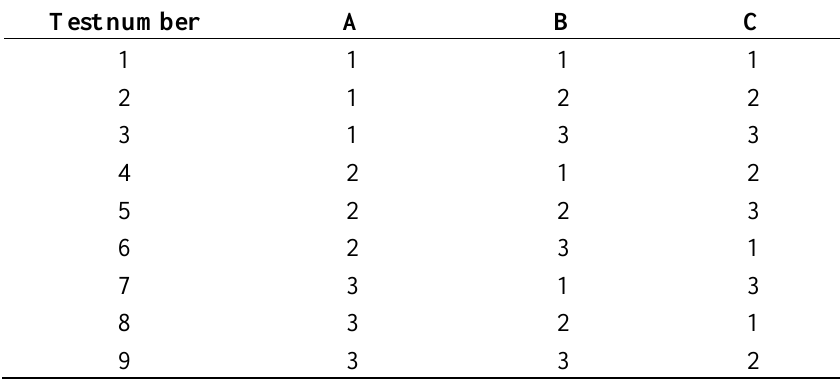
Table 3. Experimental layout using L